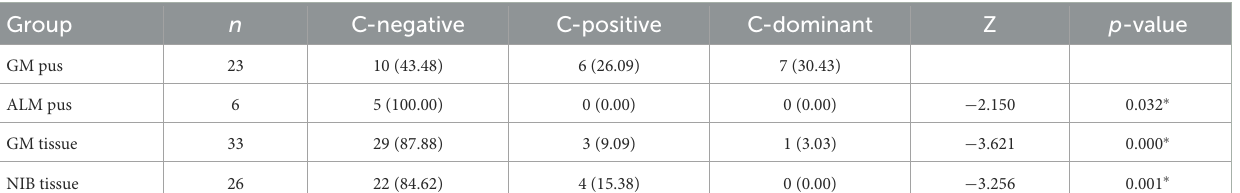
TABLE 5 Comparison of Corynebacterium degree between the four groups ( n [%]).